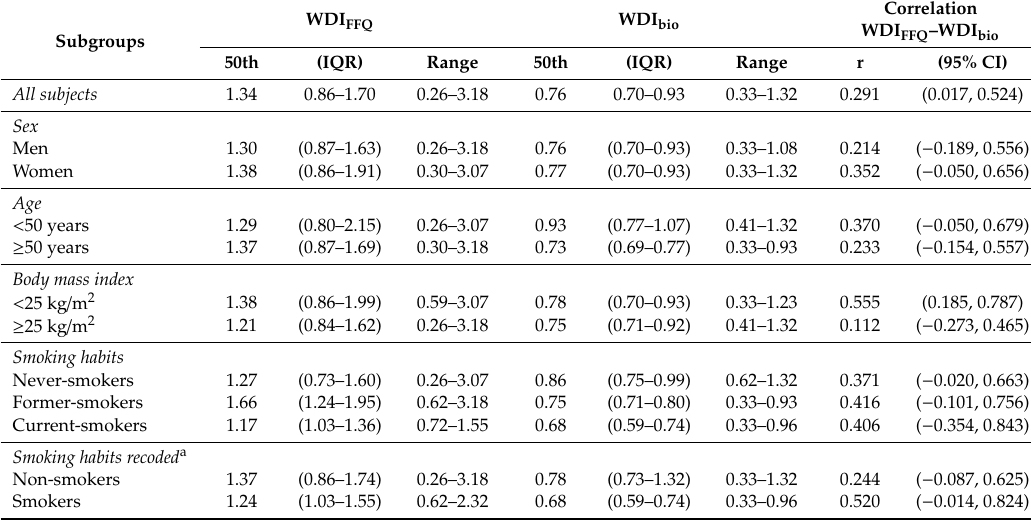
Table 2. Estimated weekly dietary intake (median (50th) and interquartile range (IQR) reported in µ g per kilograms of body weight per week) using food frequency questionnaire (WDI FFQ ) and serum cadmium biomarker levels (WDI bio ) in select subgroups, and Pearson’s correlation (r) with 95% confidence interval (CI) between WDI FFQ and WDI bio